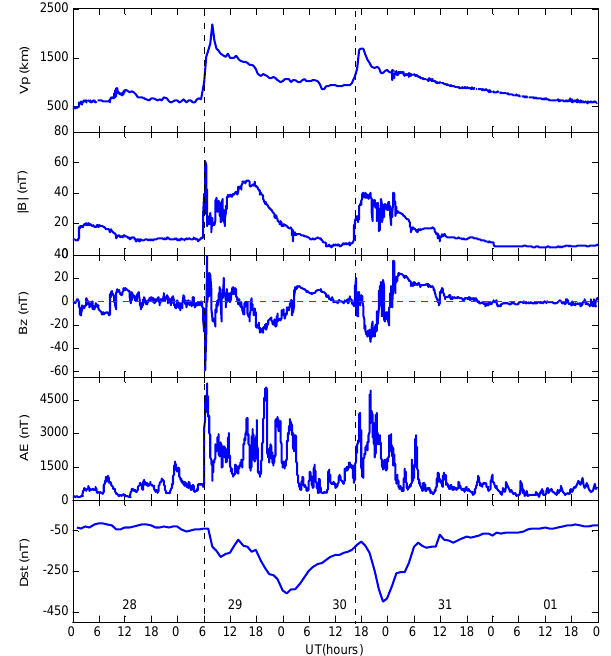
Fig. 1. From the top to bottom are the proton velocity V p , magni- tude of IMF B and its north-south component B z in the GSE coordi- nate, D st , AE indices during the magnetic storm of 28–31 October 2003. Shocks are indicated by vertical dotted